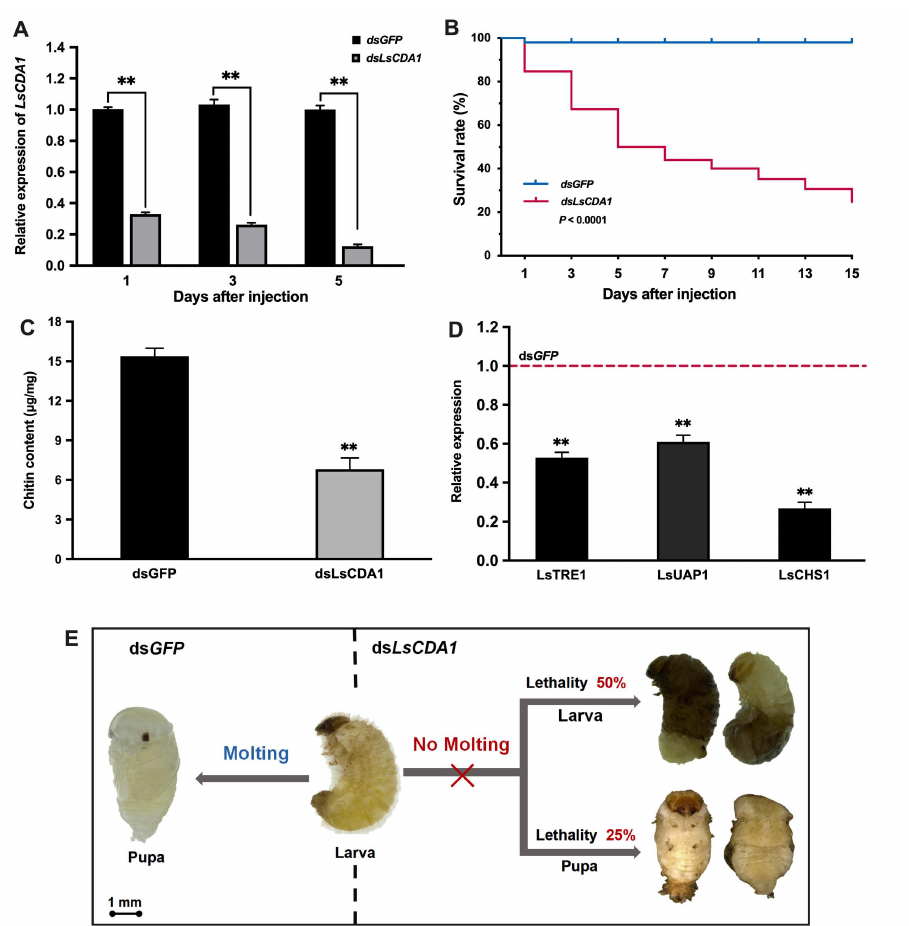
Figure 5. The e ff ect of LsCDA1 knockdown on larval–pupal molting in L. serricorne . ( A ) The relative expression levels of LsCDA1 at 1, 3, and 5 days after LsCDA1 or GFP dsRNA injection in the fifth-instar larvae. ( B ) Kaplan-Meier survival curves of L. serricorne larvae after LsCDA1 or GFP dsRNA injection. The e ff ects of LsCDA1 knockdown on chitin contents ( C ) and the expressions of three chitin synthesis pathway genes ( D ). The expression values of chitin synthesis pathway genes were calculated by comparison to the ds GFP group, which was normalized at 1. ( E ) Representative phenotypes of larvae after LsCDA1 or GFP dsRNA injection. Significant di ff erences between the RNAi group and the control group were determined using Student’s t -test (** p <